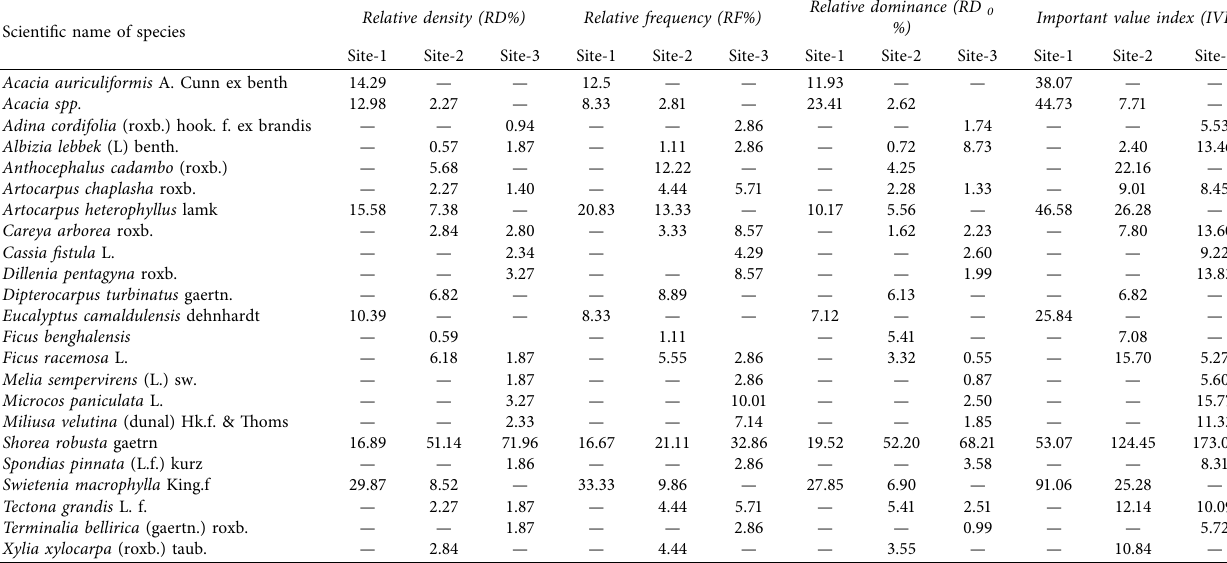
Ficus racemosa L.